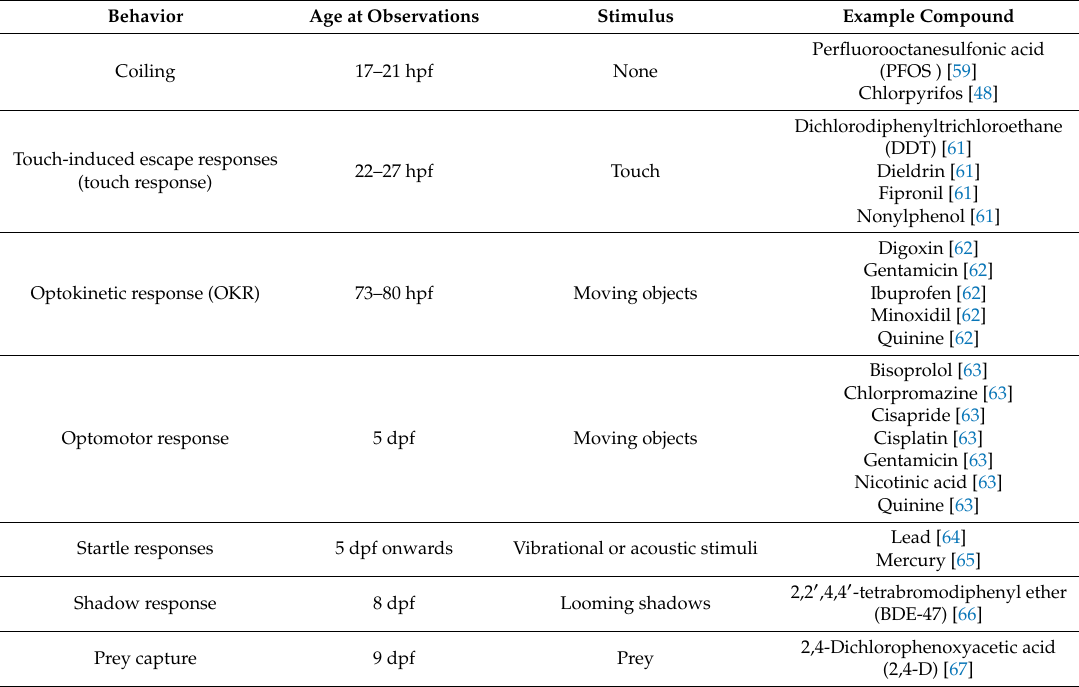
Table 2. Additional behavioral endpoints / assays in fish larvae that can be exploited for increased sensitivity and / or specificity in ecotoxicological